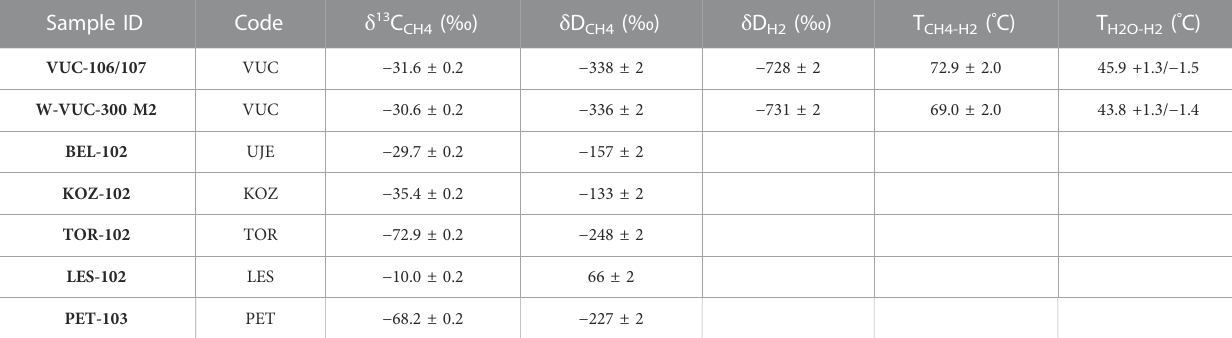
TABLE 3 Isotopic data of CH 4 and H 2 and the estimated temperature of equilibration based on the equation of Horibe and Craig (1995).